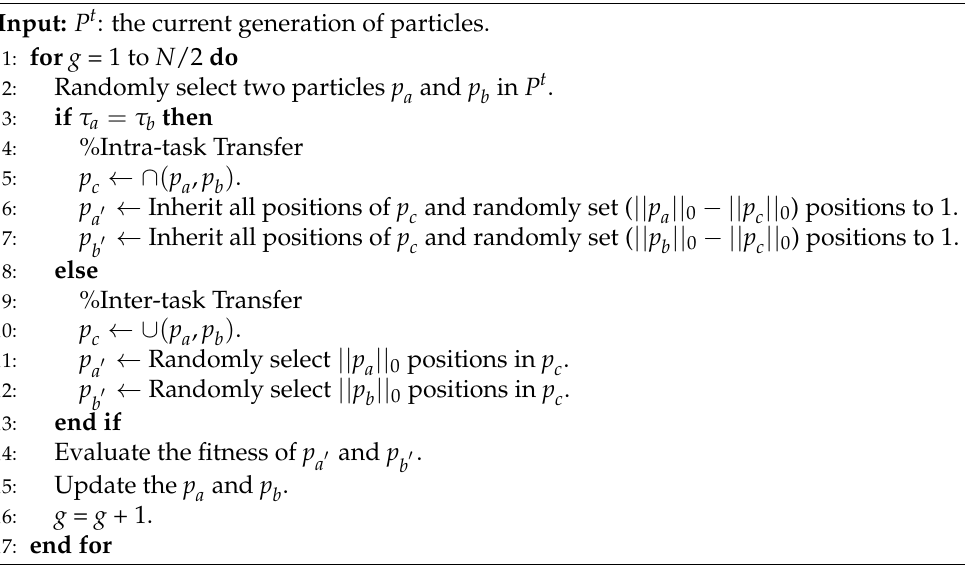
Algorithm 2 Genetic Knowledge